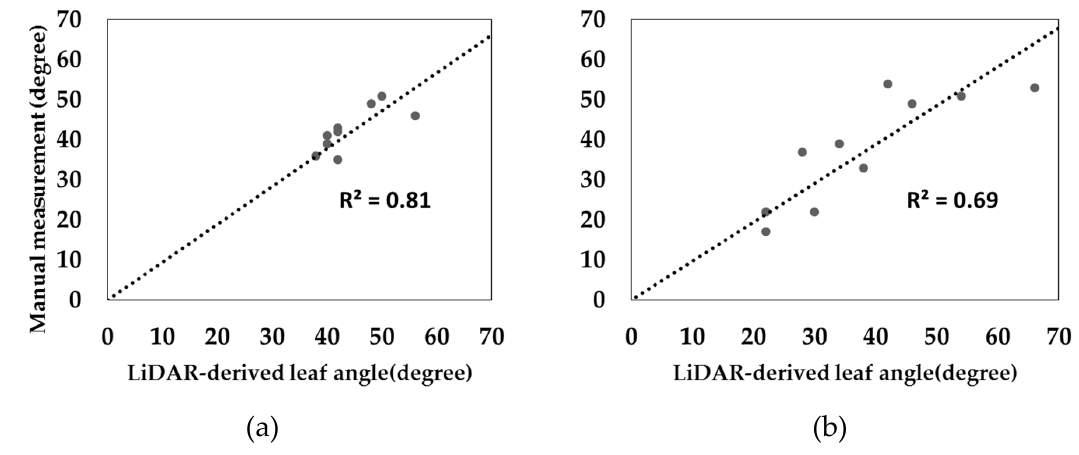
Figure 8. Comparison between manual measurement and LiDAR-derived leaf angle for ( a ) mochi trees and ( b ) Japanese camellia.